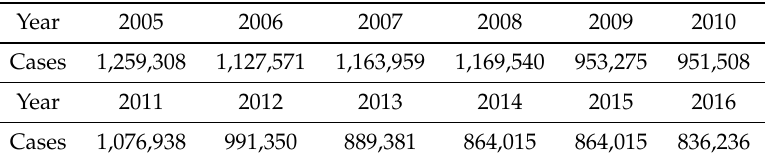
Table 1. Reported infected TB cases from 2005 to 2016 in China.